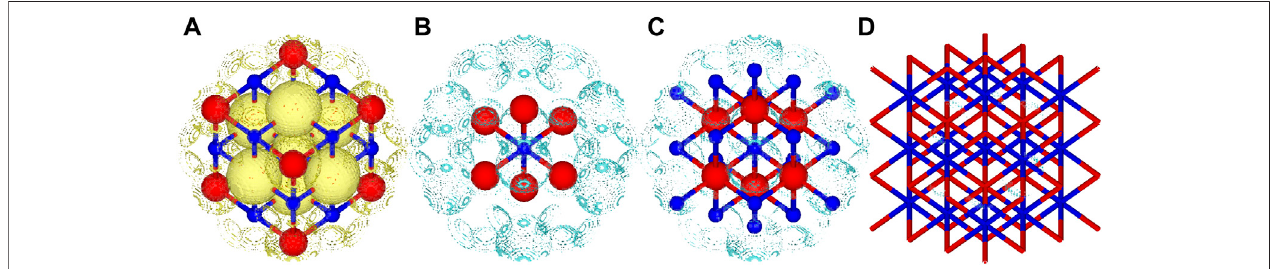
FIGURE 3 | Total and difference density plots for MgO . (A) Total density retained from the 3 × 3 × 3 periodic calculation of MgO , only a small part of the total structure visualised for brevity, (B) density difference between the [ MgO 6 ] 10 − -cluster and the 3 × 3 × 3 calculation, (C) density difference between the [ MgO ] 26 + -cluster and the 3 × 3 × 3 calculation and (D) density difference between the [ MgO 6 Mg 18 model was used for (D) in order to make the isosurface more visible. Isosurface values of 0.04 e/a 3 0 . Yellow isosurfaces correspond to positive values and cyan to negative values. Blue spheres correspond to Mg and red spheres to O .